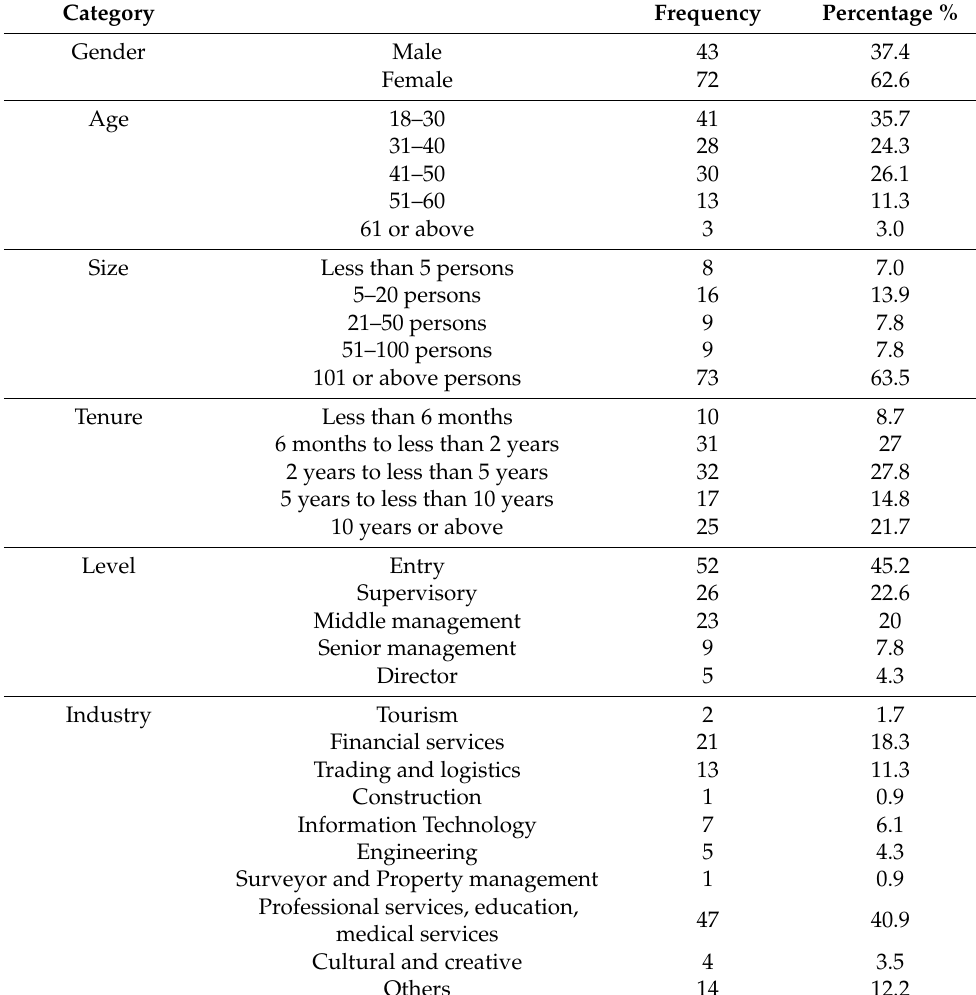
Table 1. Demographic data of